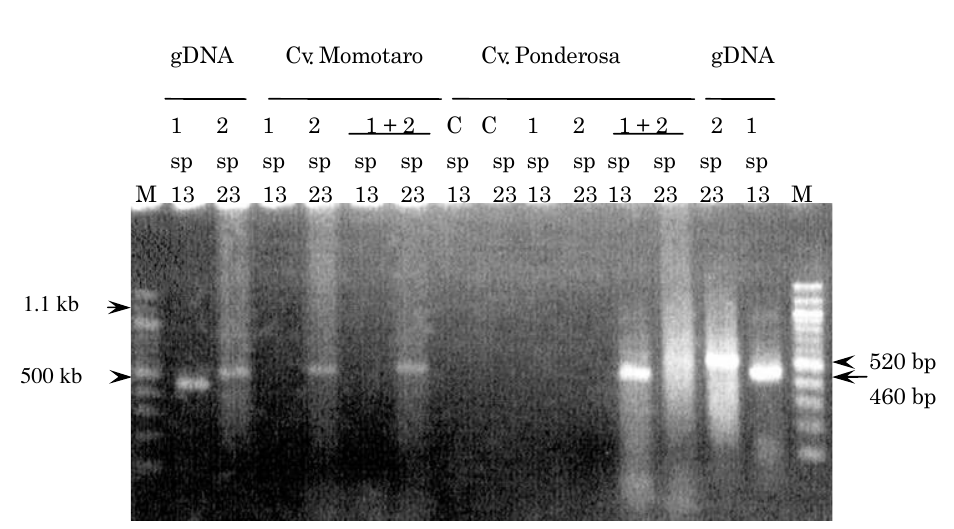
Fig. 7. Detection of Fusarium oxysporum f. sp. lycopersici race 1 and 2 from tomato (cv. Momotaro and cv. Ponderosa) leaf tissues 16 days after inoculation. Lanes, M, 100-bp DNA marker; gDNA, fungal genomic DNA extracted from Fusarium oxysporum f. sp. lycopersici race 1 and race 2 was used as a template; cv. Momotaro, total DNA extracted from the leaves of tomato cv. Momotaro inoculated singly with race 1, and with race 2, and jointly with races 1+2 was used as a template; cv. Ponderosa, total DNA extracted from the leaves of tomato cv. Ponderosa inoculated with water (C), and singly with race 1, and with race 2, and jointly with races 1+2 was used as a template; sp13, the primer set sp13 ampli fi es a ca. 460-bp fragment speci fi cally from race 1; sp23, the primer set sp23 ampli fi es a ca. 520-bp fragment speci fi cally from race